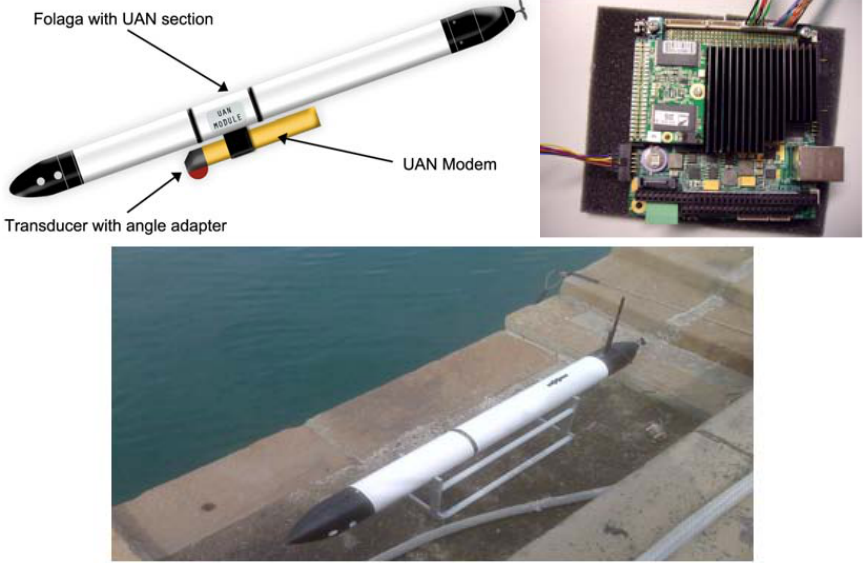
Figure 12. Top left : implementation of the proposed methodologies within the UAN project. The eFolaga vehicle [29] will carry a specific UAN payload section, with the UAN acoustic modem (developed by UAN partner Kongsberg Maritime) and electronic hardware in the dry section. Top right : the internal hardware on which the UAN system architecture has been implemented: a SECO104-CX700M board, equipped with a 1 GHz processor, 1 GB of RAM and 4 GB flash disk. Bottom : the eFolaga on the pier before an engineering test. The UAN section is inserted at the junction visible at mid-vehicle.